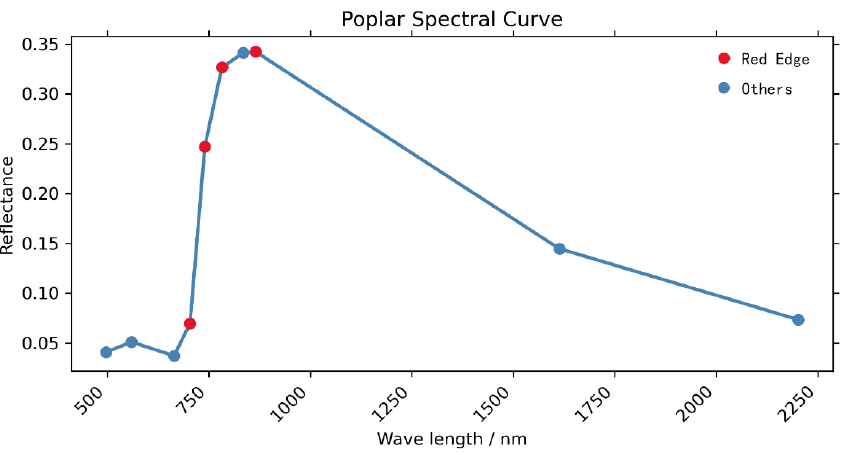
Figure 4. Location of the red edges in the S2 spectrum (with the A-star Populus Class as an example). Table 2. Table of S2 image time-series.